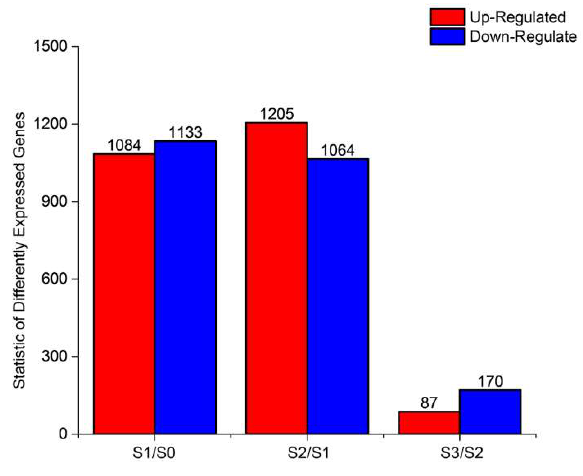
Figure 3. The statistics of DEGs.